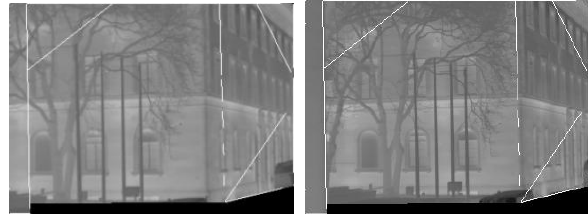
Figure 5. Image overlayed with the grid model of the building. Left: before line matching, Right: after line matching